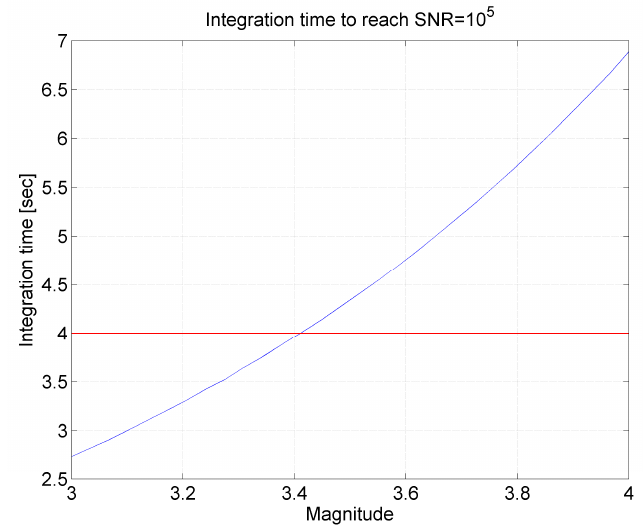
Figure 7. Integration time as function of target star V-magnitude. The SNR is 10 5 . The red line is the maximum integration time limit, i.e., 4 s.